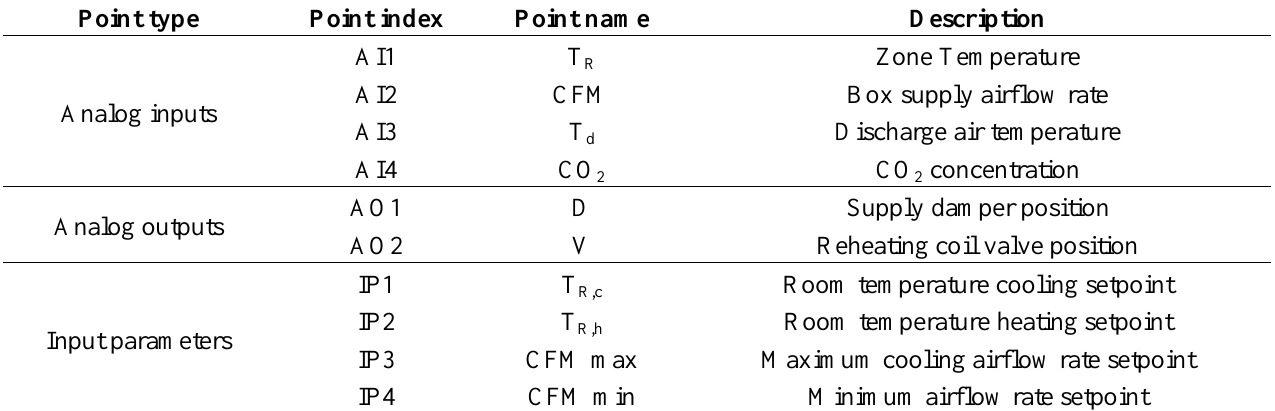
Table 6. Control parameters for proposed control